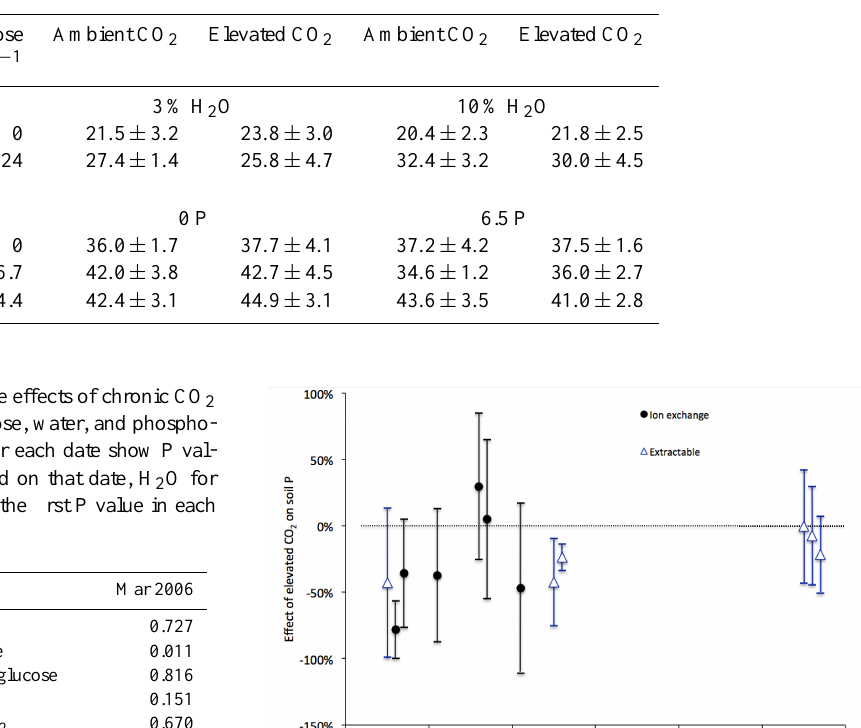
Table 5. Rates of acetylene reduction (µmolC 2 H 2 g − 1 h − 1 ) as a proxy for nonsymbiotic N 2 fixation, measured in soils from the ambient- and elevated-CO 2 treatments from laboratory incubations with added glucose and either added water (January 2006) or added phosphorus (March 2006). Values are means ± standard errors of the mean ( n = 4, January 2006; n = 5, March 2006).